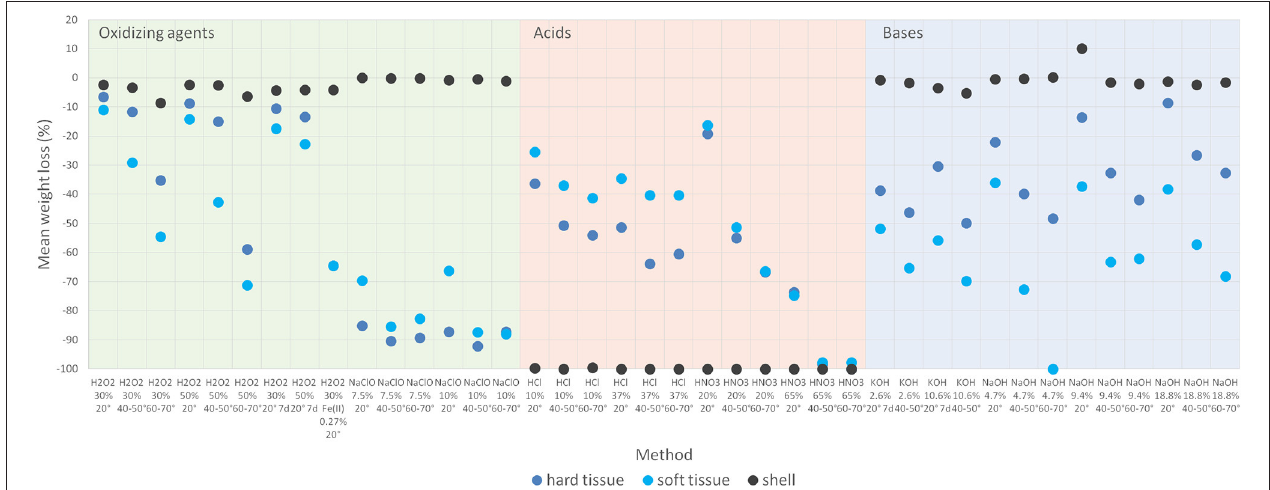
FIGURE 2 | Efficiency of tested protocols concerning biogenic organic matter digestion given as mean loss in weight (%).